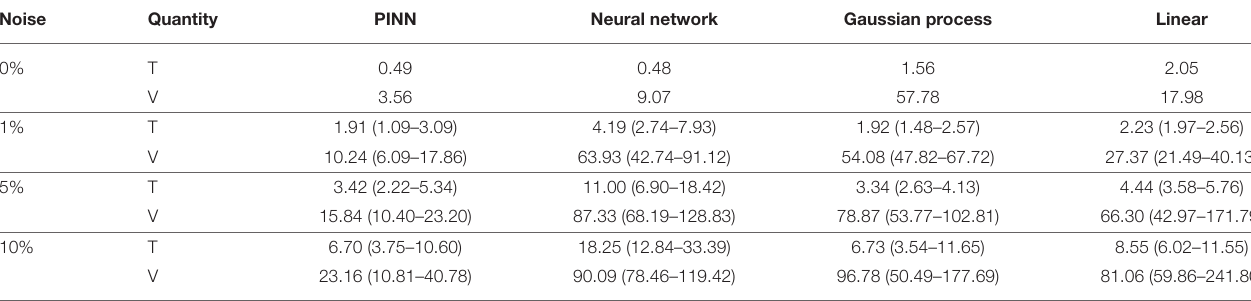
TABLE 1 | Normalized errors for benchmark problem.